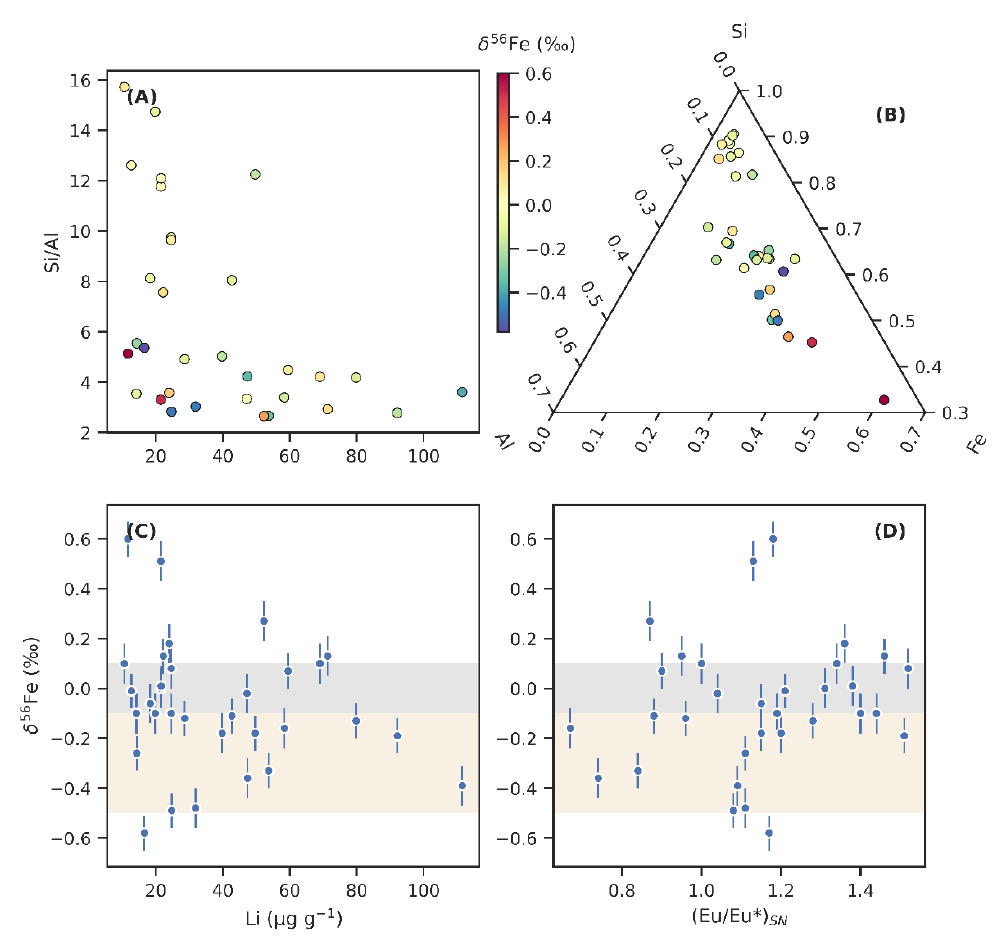
Figure 5. The relationships between detrital composition or hydrothermal influence and iron isotope ratios ( δ 56 Fe). ( A ) Lithium (Li) concentrations plotted against the ratio of silica (Si) to aluminium (Al) reveal different Si and Li-rich detrital components. ( B ) Ternary plot showing the relative Al, Si, and Fe composition of individual samples. Note that the scales are truncated. Colour scale on panels A and B indicates δ 56 Fe values; fractionated Fe is present in relatively Al- and Fe-rich, but Si- and Li-poor samples. ( C ) δ 56 Fe plotted against Li shows that Li-rich samples tend towards negative δ 56 Fe values. ( D ) δ 56 Fe shown against the europium anomaly (Eu/Eu*) SN , a proxy for hydrothermal influence. No clear covariation is discernible.